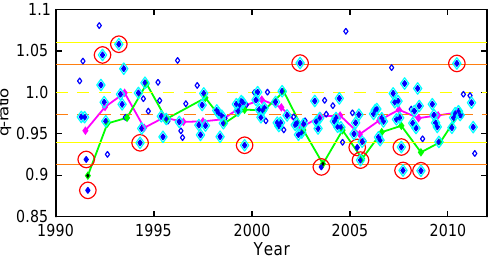
Fig. 1. Ratios between measurement and model at 345nm for different averaging intervals (“q-ratios”). Open blue symbols: monthly q-ratios ( q monthly (y,m)) ; solid blue symbols: subset of q monthly (y,m) where the median was calculated from at least 10 spectra; pink solid symbol connected by lines: q annual (y) ; green solid symbol connected by lines: q summer (y) . Outliers are indicated by red circles and discussed in Appendix A. q monthly (y,m) used for the correction are indicated by a cyan border. Values of q summer (y) not used for the correction have a black core. Broken lines drawn in yellow (orange) indicate 1.0 ( ¯ q monthly ) . Solid lines drawn in yellow (orange) indicate the range of 1 ± 0.060 ( ¯ q monthly ± 0 . 060 )